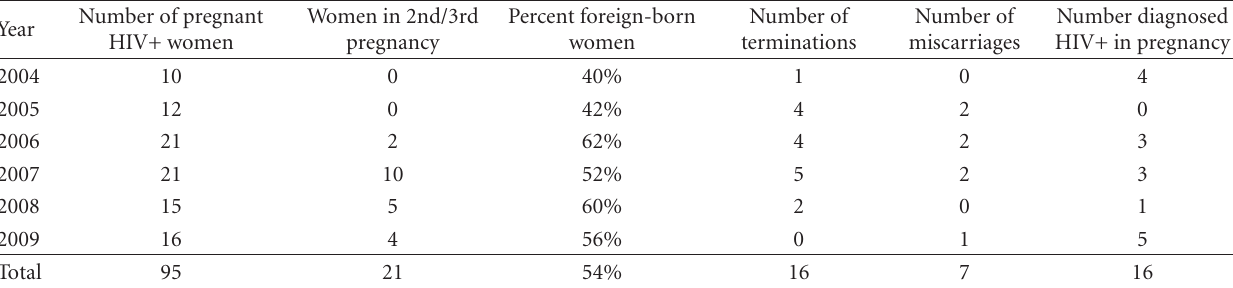
Figure 1: Continent/region of origin among HIV-infected pregnant women in RI. Table 1: Trends in pregnancies among HIV-infected women followed by the Immunology